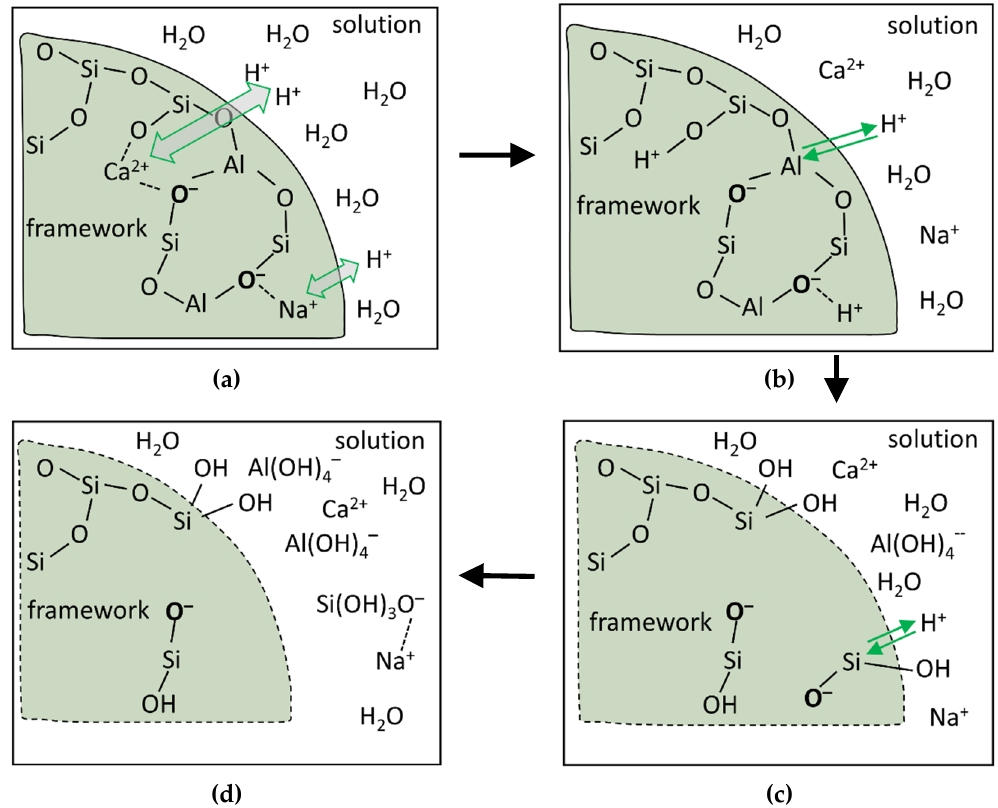
Figure 9. Schematic illustration of the dissolution of slag (after [51]). For clarity, additional bonds between Si and O as well as between Al and O are not shown. First, the modifying elements are initially released through the metal/proton exchange reactions, as shown in ( a ); then, hydrolysis of the bonds between Al and O starts, as shown in ( b ); afterwards, the bonds between Si and O start to break, as shown in ( c ); finally, Al and Si are released, as a result of which the framework is gradually dissolved, as shown in ( d ).